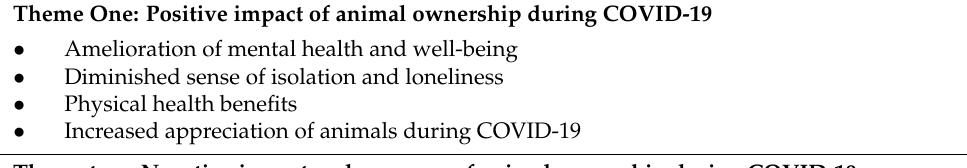
Table 5. Themes and related sub-themes. Theme One: Positive impact of animal ownership during